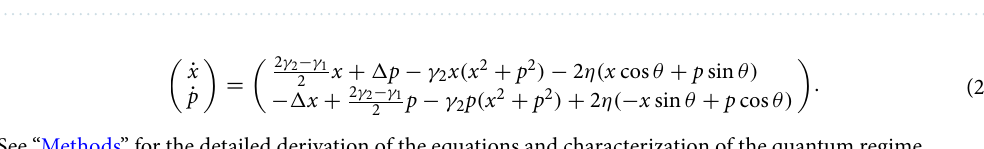
Figure 2. Quantum activator–inhibitor unit. ( a ) Nullclines of the deterministic vector field of Eq. (2). Blue and green curves indicate the sets ( x , p ) satisfying obtained from the semiclassical SDE. ( c ) Stationary Wigner distribution W ( x , p ) obtained from the QME. The parameters are �